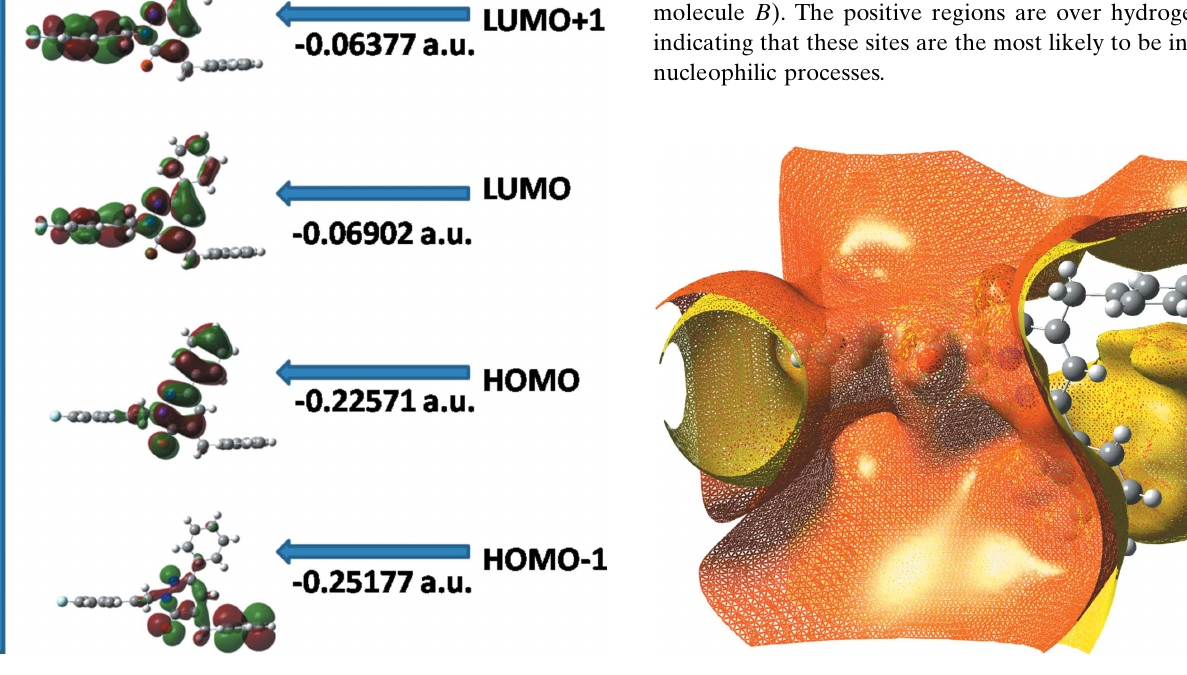
Figure 4 Electron distribution of the HOMO (cid:5) 1, HOMO, LUMO and the LUMO+1 energy levels for the title compound.